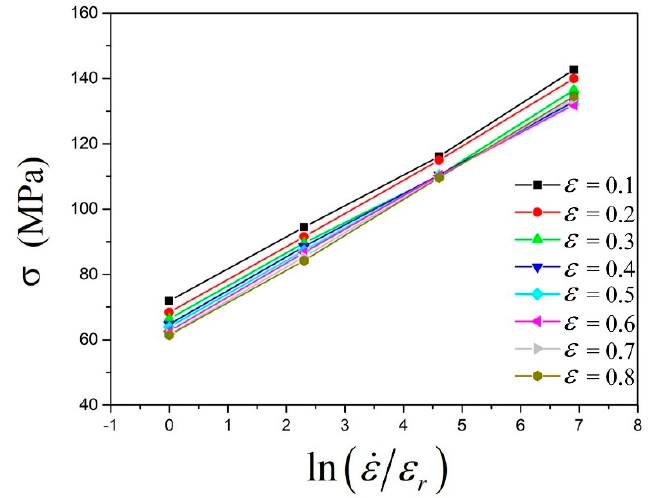
Figure 3. The relationship between σ and ln ε / ε r at T = 593.15 K (320 ◦ C). When considering the effect of temperature variation on stress, it can be found from Figure 4a that the logarithm of the stress is linear with the difference between the current temperature and the reference temperature ( T − T r ) , when the strain rate is 0.01 s − 1 , and the relationship between the stress and the temperature can be expressed by Equation (6). where T r = 593.15 K (320 ◦ C), M is a parameter reflecting the coupling effect of temperature and strain rate, which can be expressed as Equation (7).